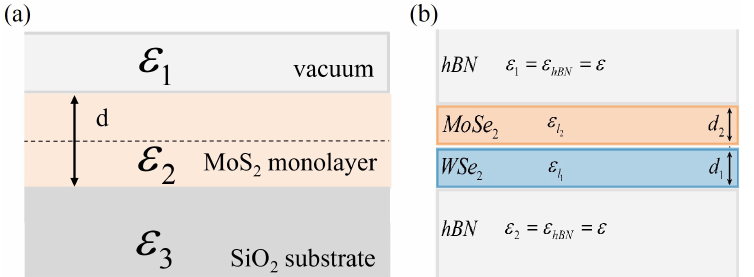
Figure 10. ( a ) Schematic picture of the dielectric environment of the MoS 2 monolayer on the SiO 2 substrate. ( b ) Slab model of the MoSe 2 /WSe 2 heterostructure. Each of the MX 2 layers with the width d 1,2 , respectively, is described by the dielectric constant ε l 1 , l 2